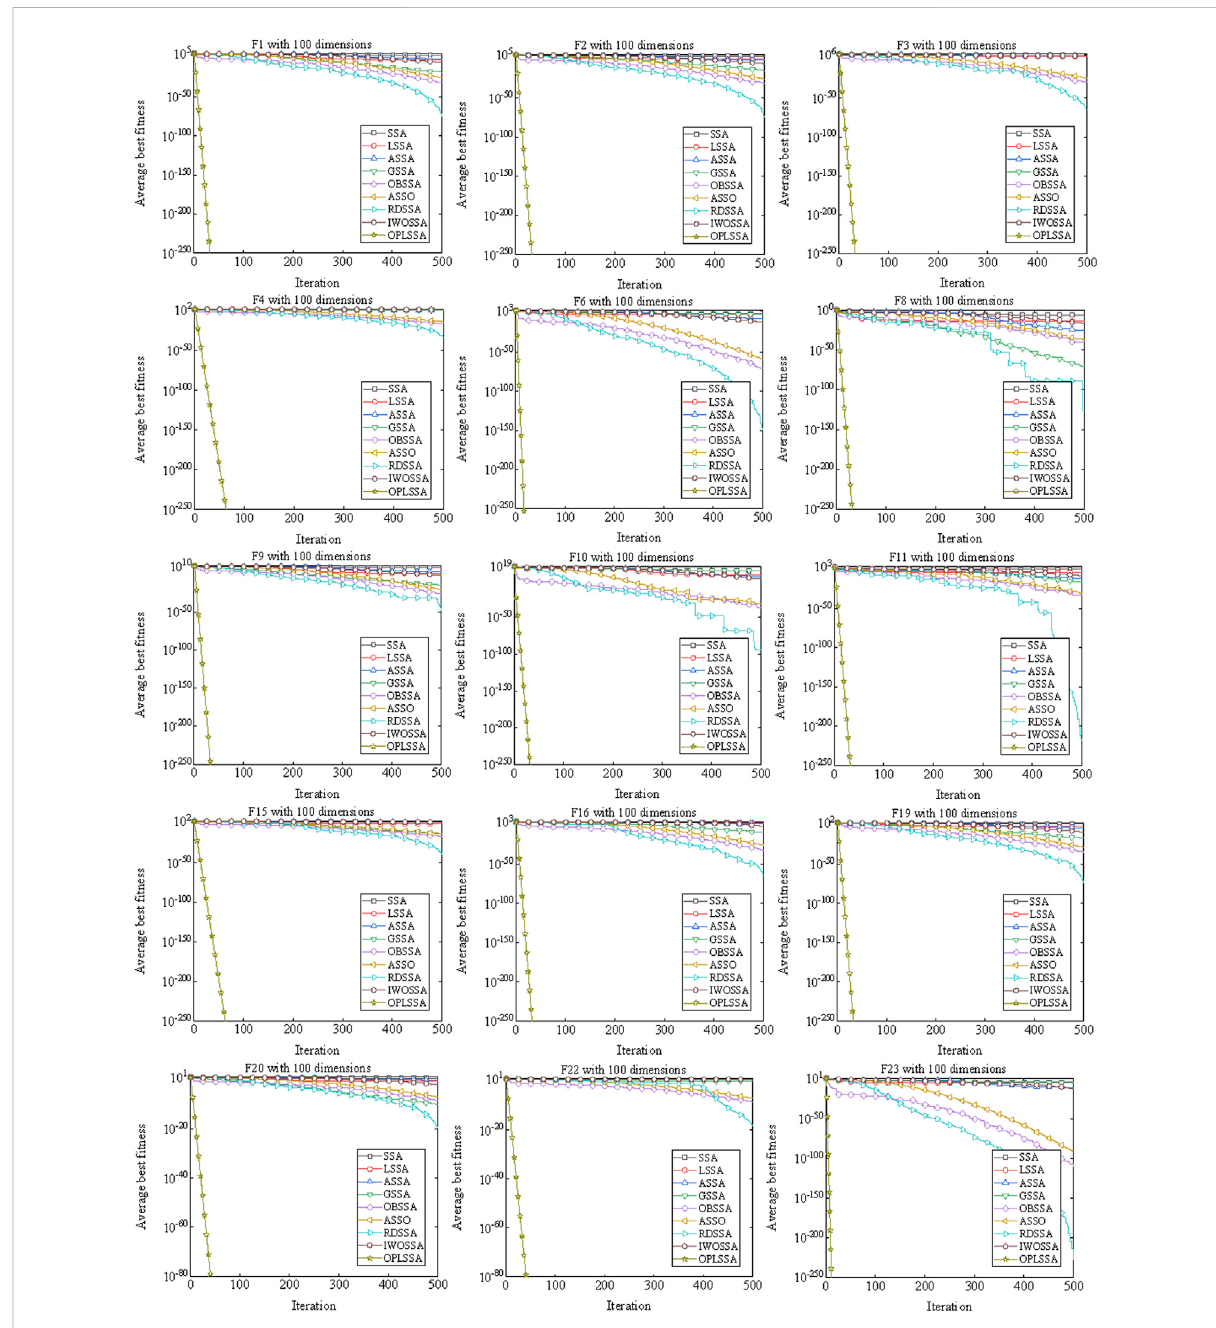
FIGURE 7 Convergence curves of OPLSSA and other SSA-based algorithms on 15 representative